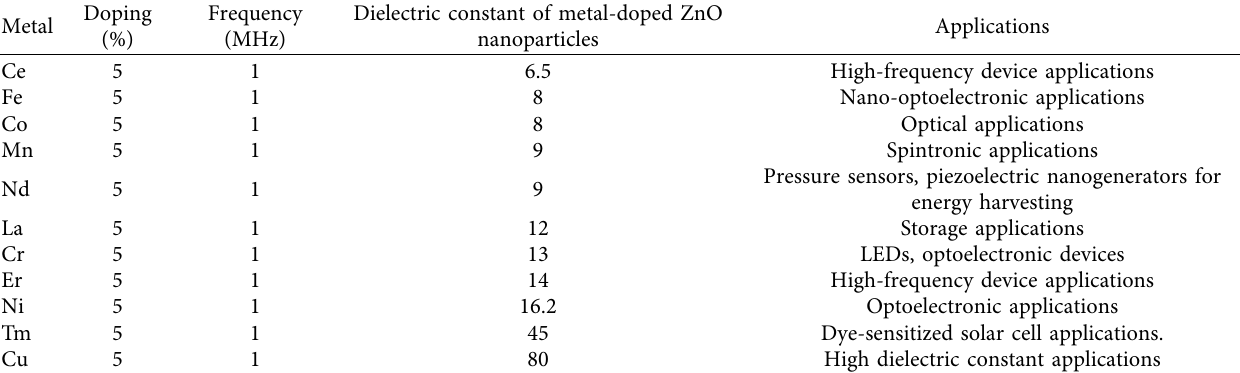
Table 3: Various metal-doped ZnO nanoparticles and their potential applications.